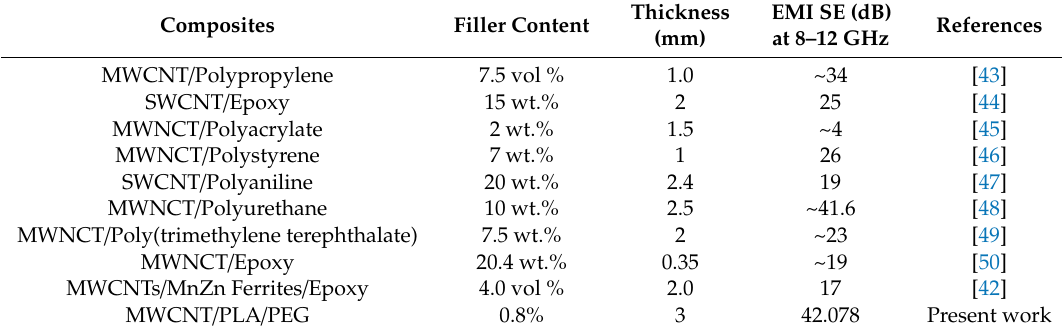
Table 4. Comparative of EMI shielding performance of present work to different polymer composites [42].